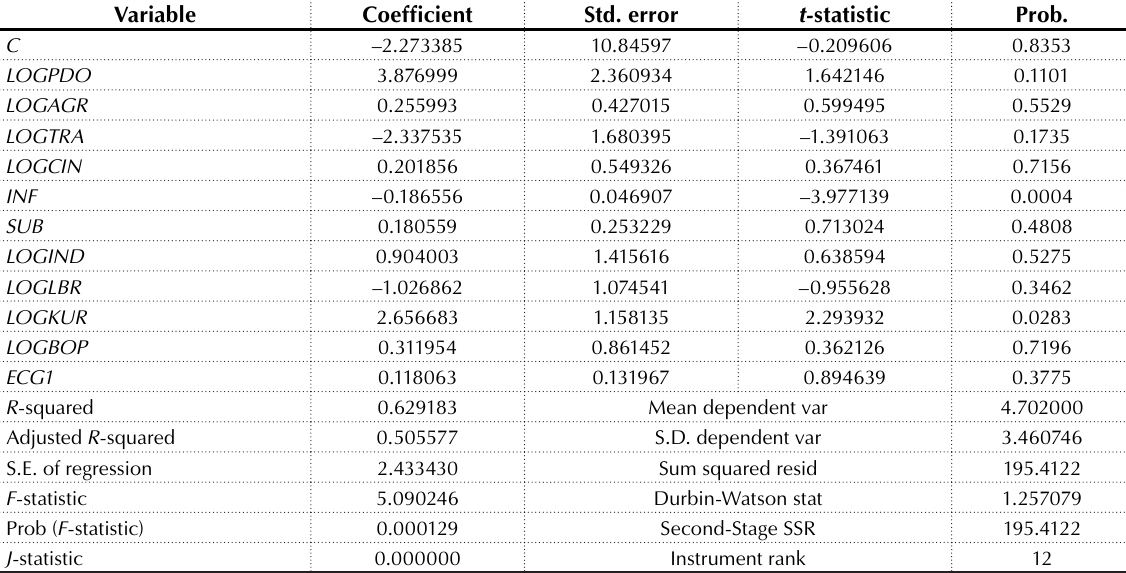
Table 3. Simultaneous equations of economic growth